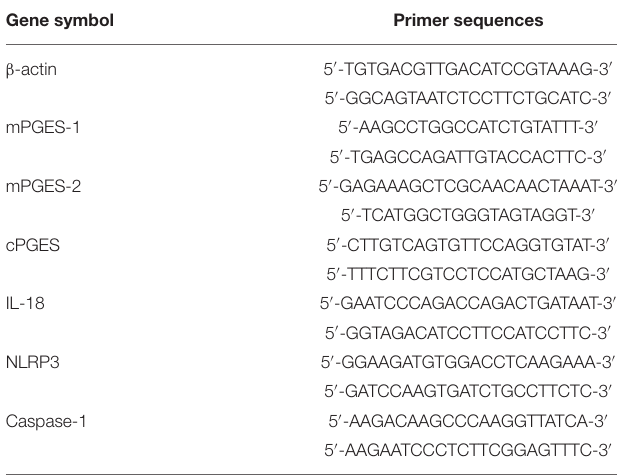
TABLE 1 | Primer sequences for